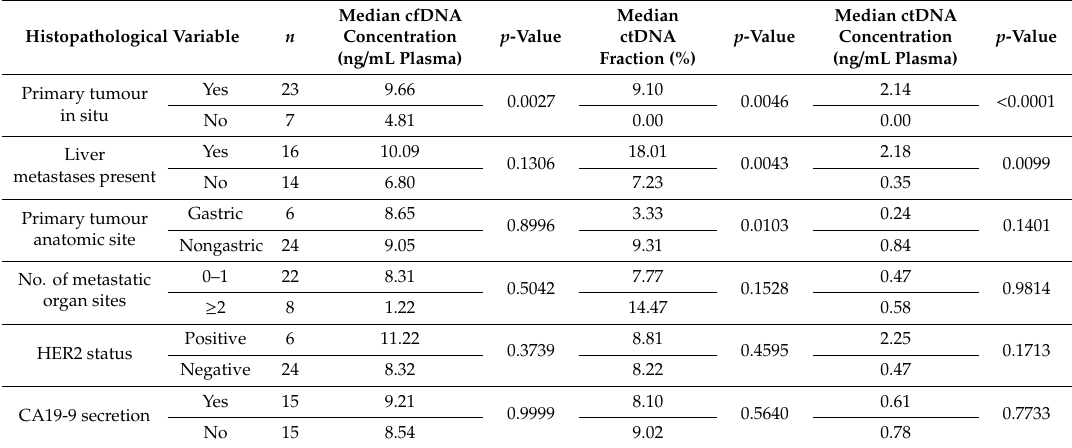
Table 2. Correlationof cfDNAconcentration, medianichorCNActDNA fraction, and ctDNAconcentration with clinical and laboratory variables ( p -values Mann–Whitney